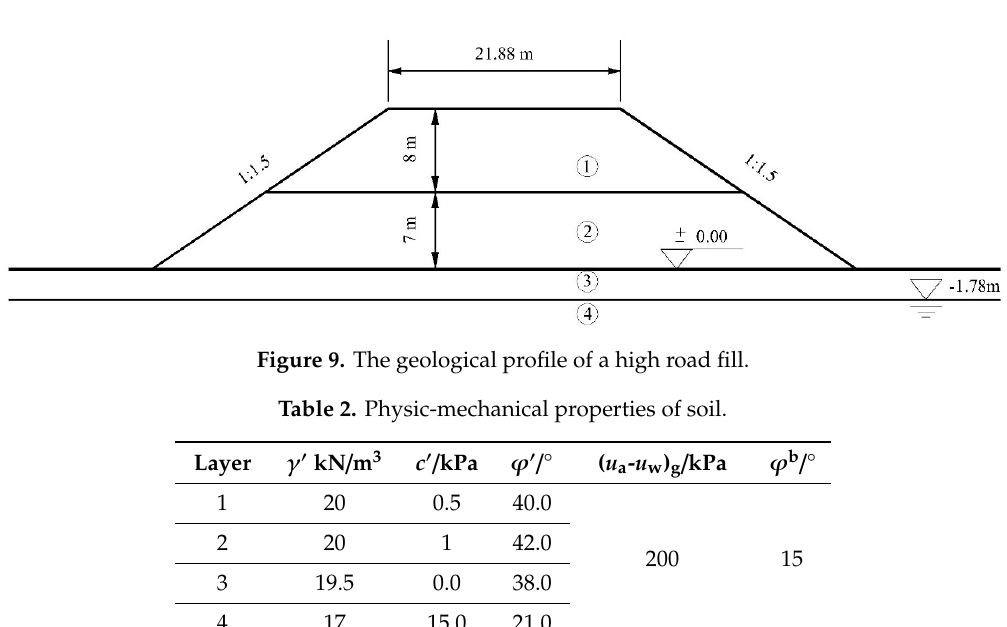
Figure 9. The geological profile of a high road fill.